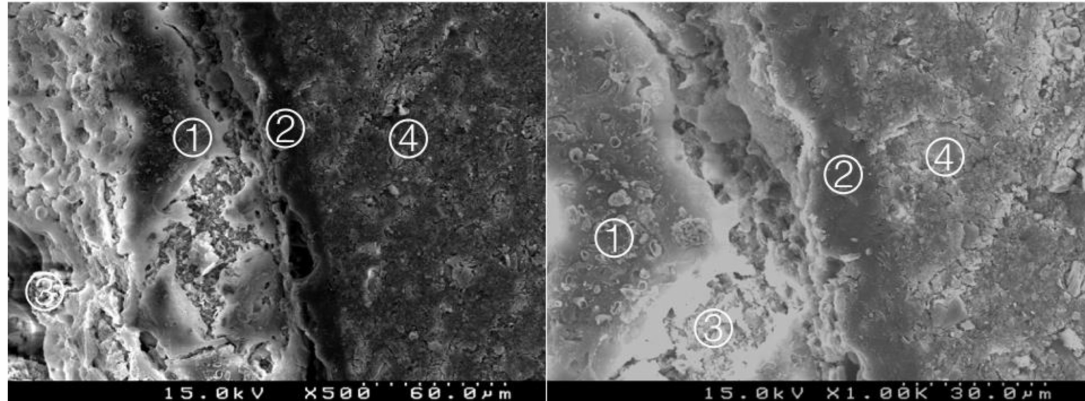
Figure 9. Group 7 (BiodentineU1I): deep interdigitation between the adhesive and the cement, with particles of cement involved by the adhesive. A thick hybrid layer is presented 1 (cid:13) between the adhesive 2 (cid:13) and the Biodentine TM 3 (cid:13) . Composite resin 4 (cid:13) (original magnification 500 × and 1000 ×